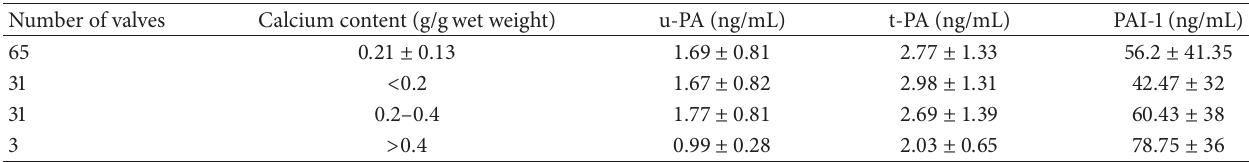
Table 2: Description of the studied valves with AS. Calcium content of the valves and concentrations of plasminogen activators and inhibitor of the fibrinolytic system released during 24 hours by the AS valves into the incubation medium (valve-conditioned medium) were measured. Results are expressed as mean ±